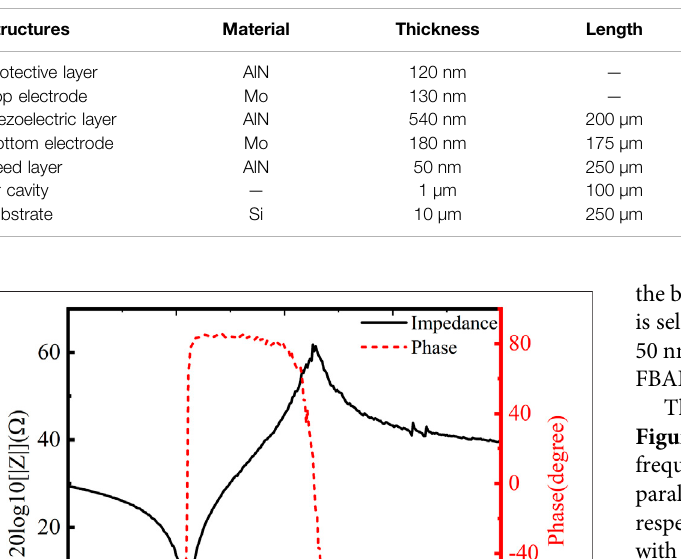
TABLE 2 | Structural optimization parameters of the FBAR.